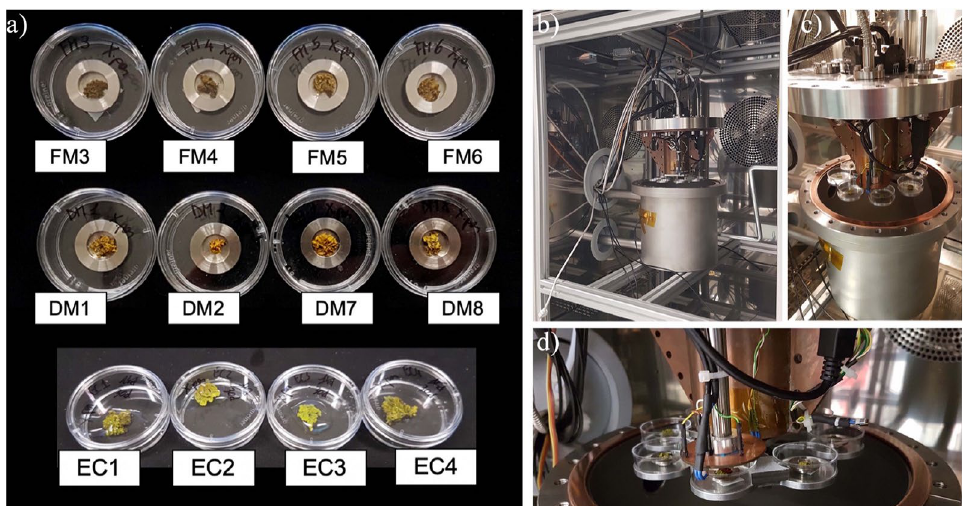
Figure 1. On the left ( a ), samples of X. parietina used in this experiment before the 30 days exposure. First row: Full Mars (FM) samples; second row: Dark Mars (DM) samples; third row: External Control (EC) samples. On the right, PASLAB at Berlin DLR. ( b ) Opened climate chamber and opened experiment chamber. ( c ) Detail of the opened experiment chamber with the sample holders on the turntable. ( d ) Detail on the sample position 1 with the above Mini PAM optical